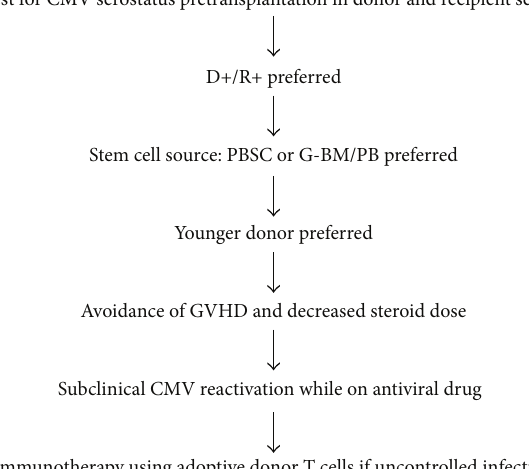
Figure 2: Proposed algorithm for improving CMV-specific IR fol- lowing haplo-SCT. CMV, cytomegalovirus; D+/R+, CMV-positive recipients of grafts from CMV-positive donors; PBSC, peripheral blood stem cell; G-BM/PB, combining G-CSF-primed bone marrow (G-BM) and peripheral blood (G-PB) harvests; GVHD, graft- versus-host